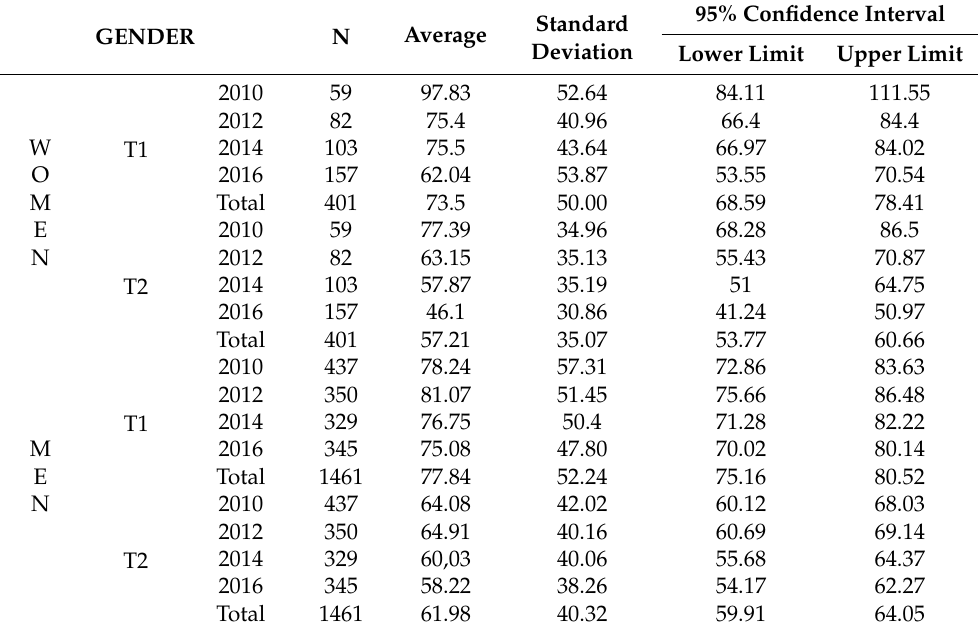
Table 5. Descriptive comparison among World Championships in T1 and T2 by